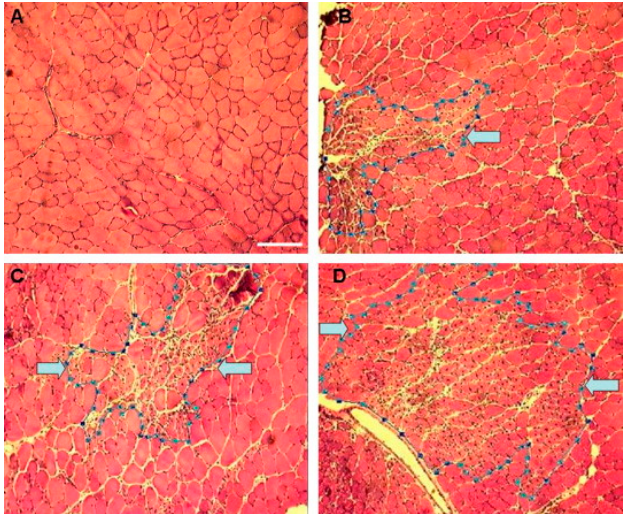
Figure 6. Images captured by 20× objective show damaged muscles after injection of transfection solution with or without ultrasound irradiation. Broken lines and arrows indicate the regions of injured muscles. Panel ( A ): no injection; panel ( B ): injection of transfection media containing DNA alone; panel ( C ): injection of transfection media containing DNA + 10% Optison; panel ( D ): injection of transfection media containing DNA + 10% Optison followed by US. The white scale bar indicates 100 μ m. (Reprinted from Chen et al. [18] with permission.)